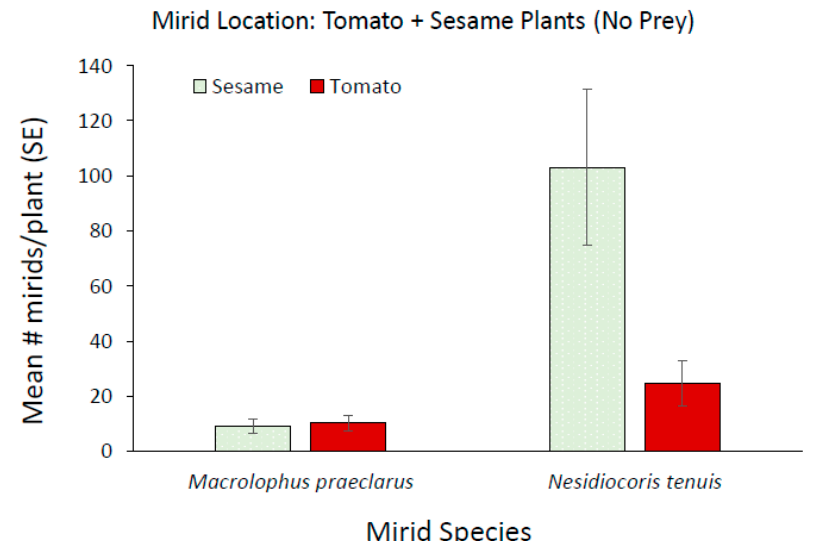
Figure 4. Mean (±SE) number of Macrolophus praeclarus and Nesidiocoris tenuis adults and nymphs found on clean (no whitefly prey added) tomato and sesame plants five weeks after adding four adult mirids (two males and two females).